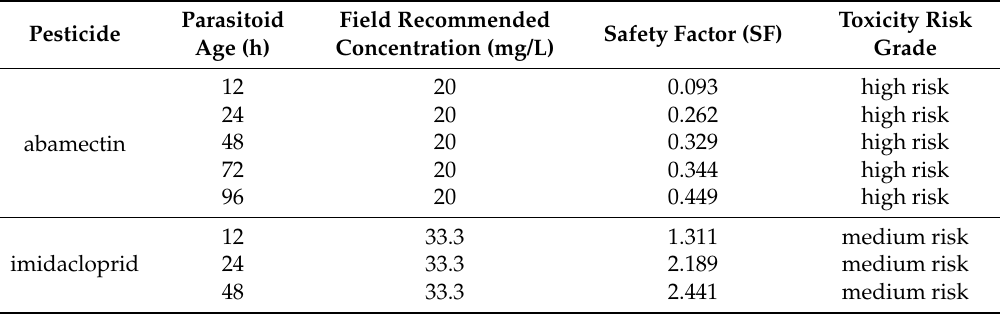
Table 4. The toxicity risk grade of abamectin and imidacloprid to Encarsia formosa adults.